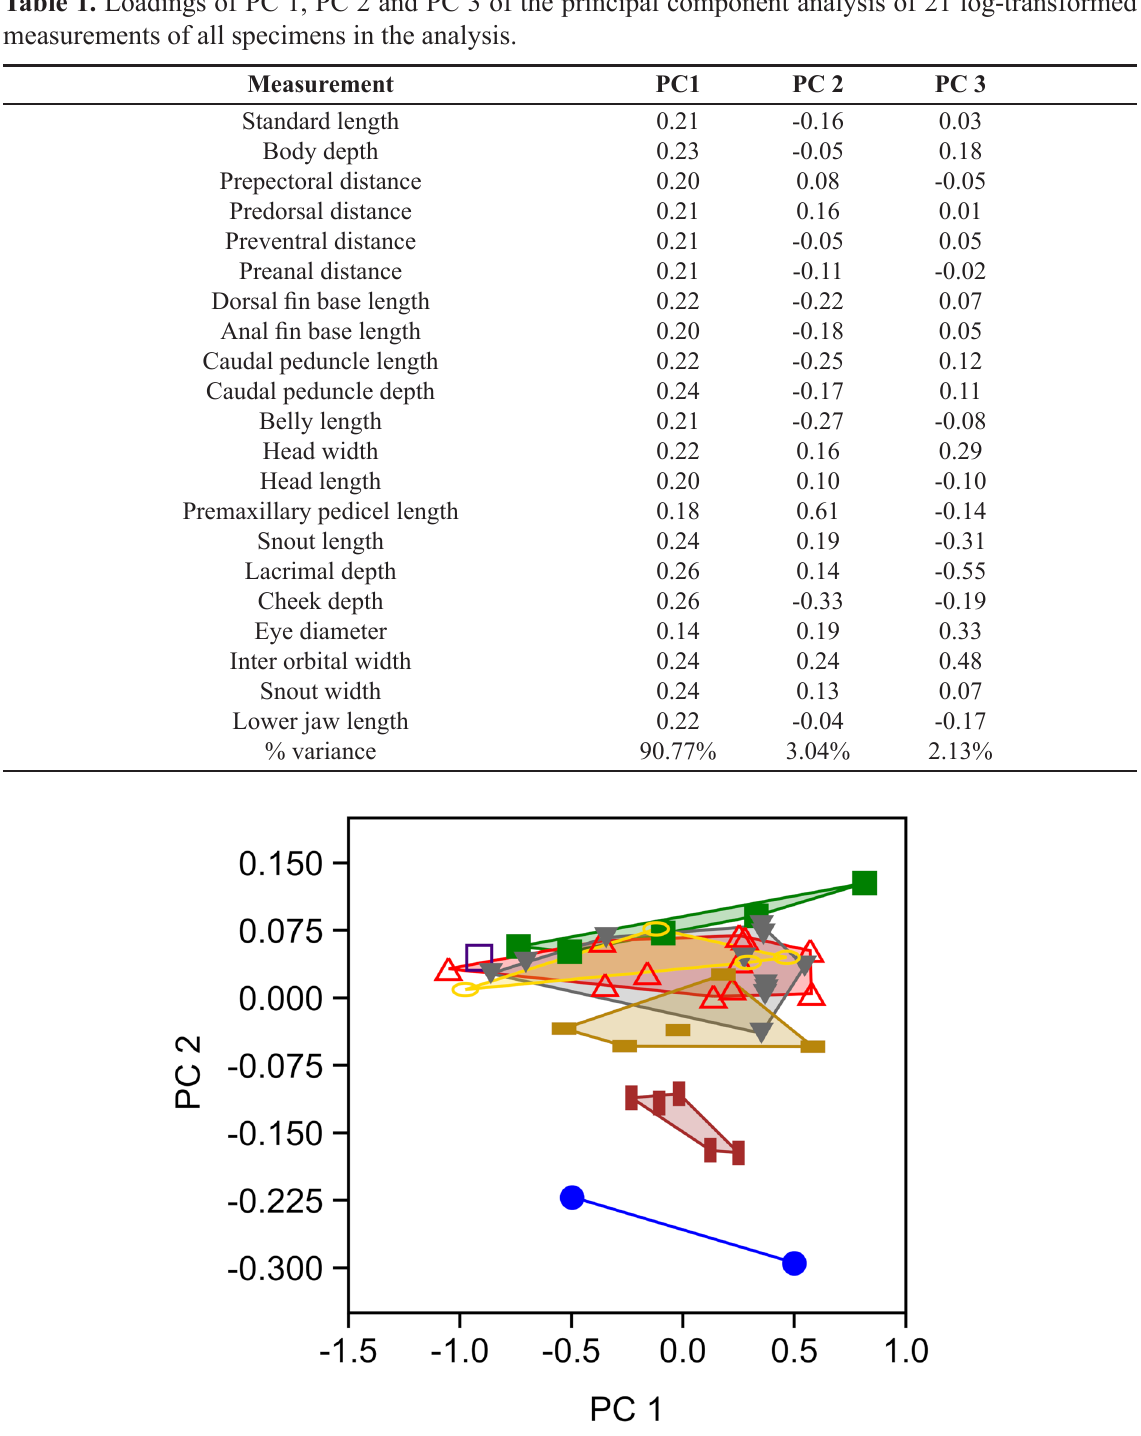
Fig. 1. Scatter plot of PC 1 against PC 2 for a principal component analysis of 21 log-transformed measurements of all specimens studied (n = 44). Protomelas krampus sp. nov. = blue dot; Hemitaenio- chromis brachyrhynchus Oliver, 2012 = purple square; H. urotaenia (Regan, 1922) = green square; Hemitaeniochromis sp. ‘ insignis like’ = red triangle; P. spilopterus (Trewavas, 1935) = grey inverted triangle; P. insignis (Trewavas, 1935) = golden diamond; Caprichromis liemi (McKaye & Mackenzie, 1982) = light brown dash; C. orthognathus (Trewavas, 1935) = dark brown